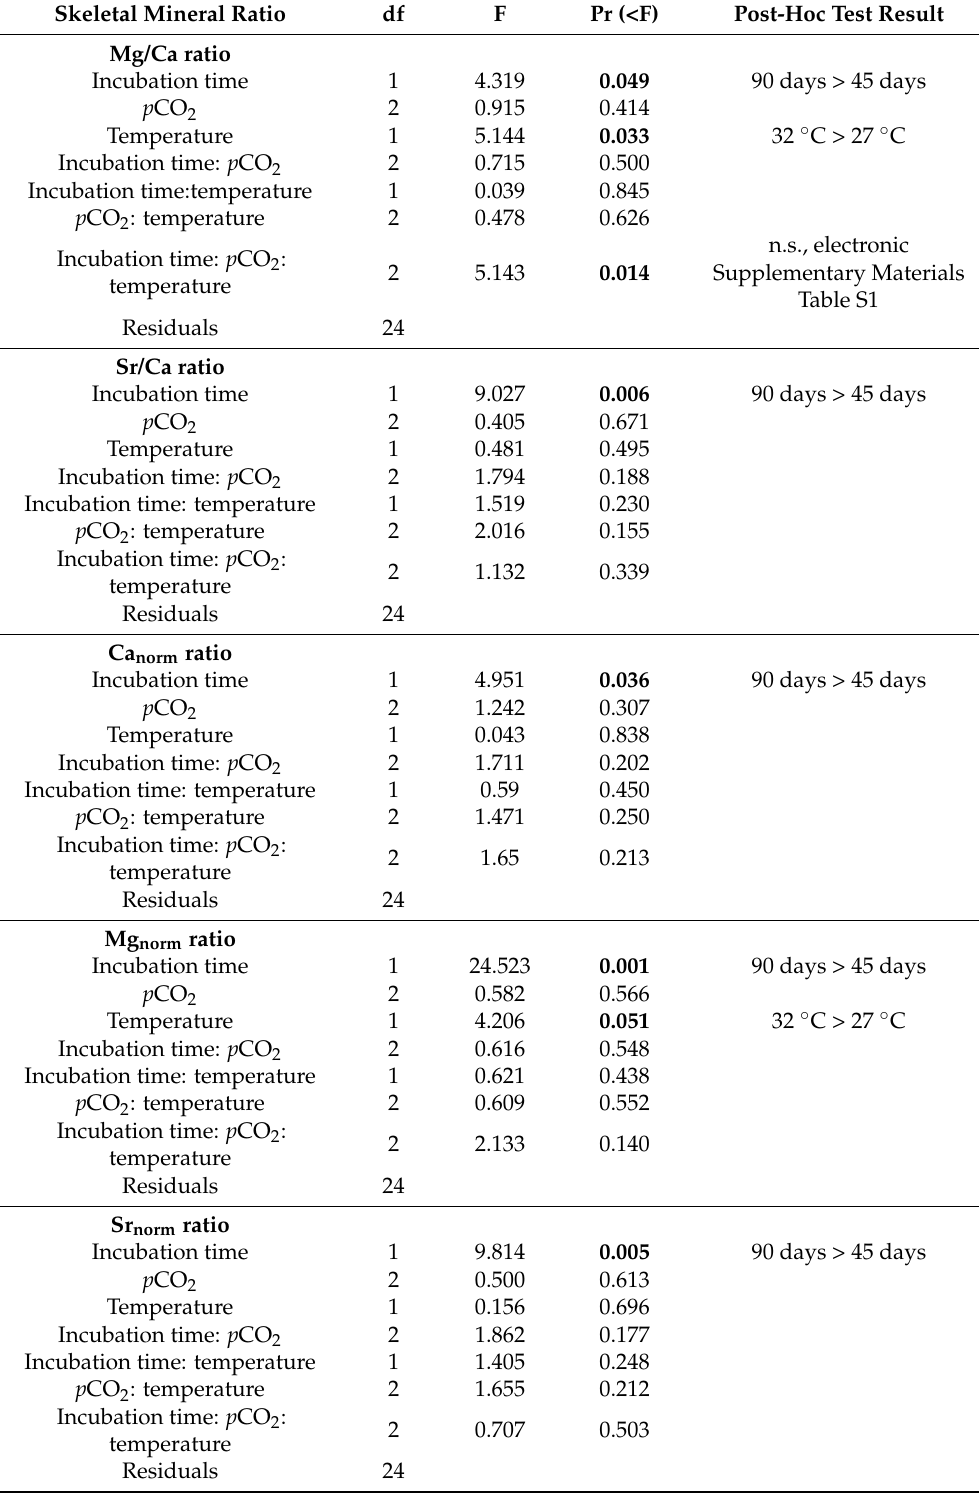
Table 2. Summary of three-way ANOVA results for the skeletal mineral ratios of A. yairi exposed to temperature (27 ◦ C, 32 ◦ C) crossed with elevated p CO 2 (455 µ atm, 1052 µ atm, 2066 µ atm) treatments for 45 and 90 days incubation time. Tukey HSD post hoc tests were performed where ANOVA results indicated significant effects of one or several factors (incubation time, p CO 2 , temperature) with p -values adjusted for multiple testing (p adj ). Bold terms indicate a significant difference ( p <